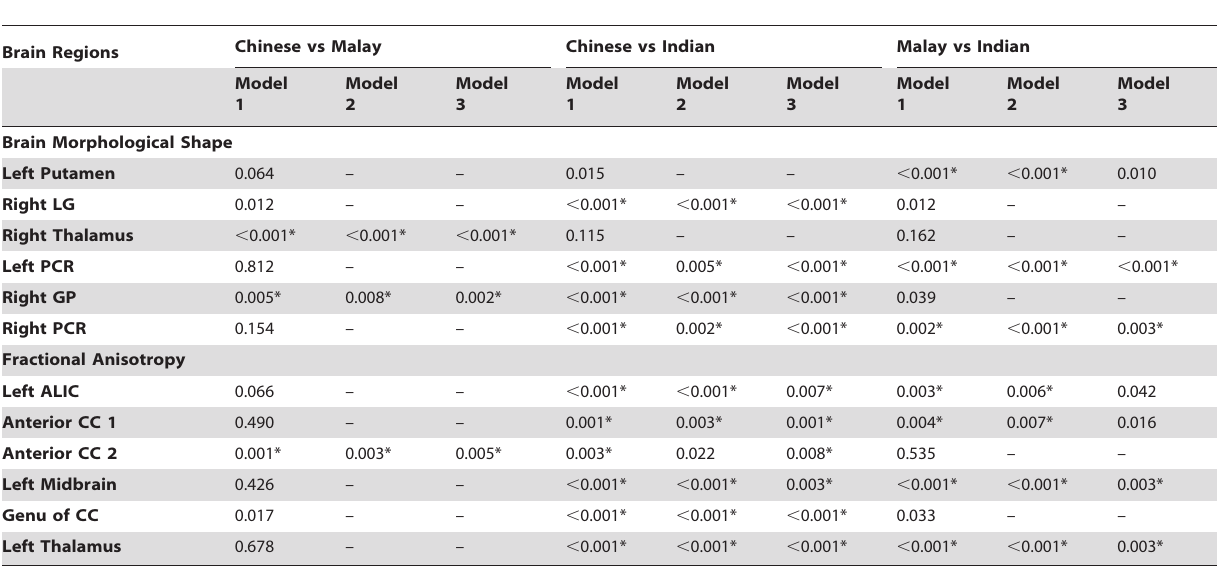
Table 4. P-values for pairwise group comparisons on brain morphological shape and fractional anisotropy within each brain region listed in Table